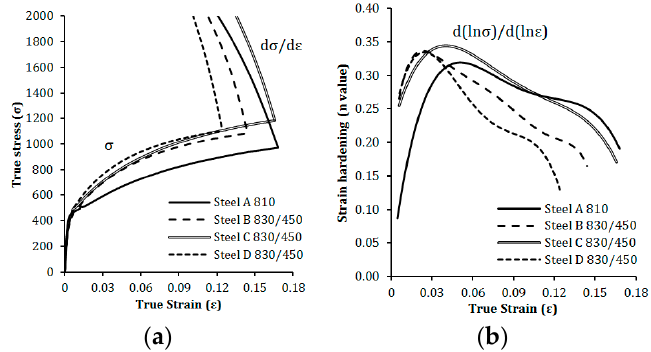
Figure 2. True stress-true strain and d σ /d ε curves ( a ) and incremental strain hardening n values ( b ). Table 6. True thickness strain at fracture, true fracture strain, and true uniform elongation values of the investigated steels.